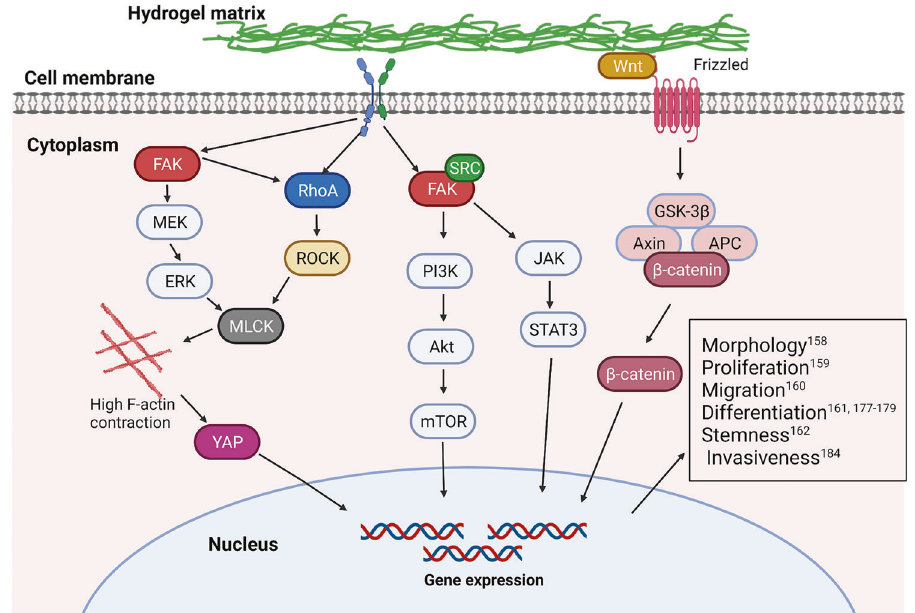
Fig. 3 The outlined image for indicating the representative cellular mechanosignaling pathways induced by varied hydrogel stiffness. Hydrogel stiffness was demonstrated to correlate with many activations of focal adhesion kinase (FAK) signaling, RhoA signaling, and Wnt signaling and simultaneously regulate cell morphology, proliferation, migration, invasiveness, differentiation, and stemness. 417,418 The fi gure is made with biorender